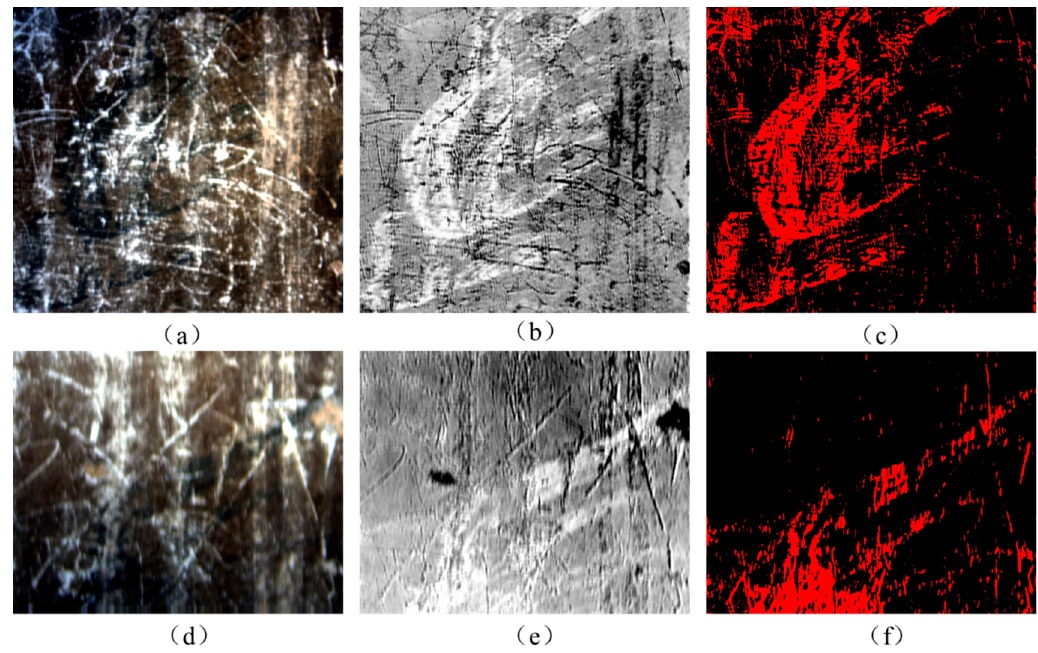
Figure 7. The extraction of the hidden information using density slicing: ( a ) Color image of area 1 (synthesized from original hyperspectral images); ( b ) the DN value of area 1 is transformed to start from 0 and the pattern is highlighted in white; ( c ) the pattern of area 1 is extracted by density slicing with threshold of 7.95; ( d ) color image of area 2; ( e ) the DN value of area 2 is transformed to start from 0 and the pattern is highlighted in white; ( f ) the pattern of area 2 is extracted by density slicing, with a threshold of 6.55.